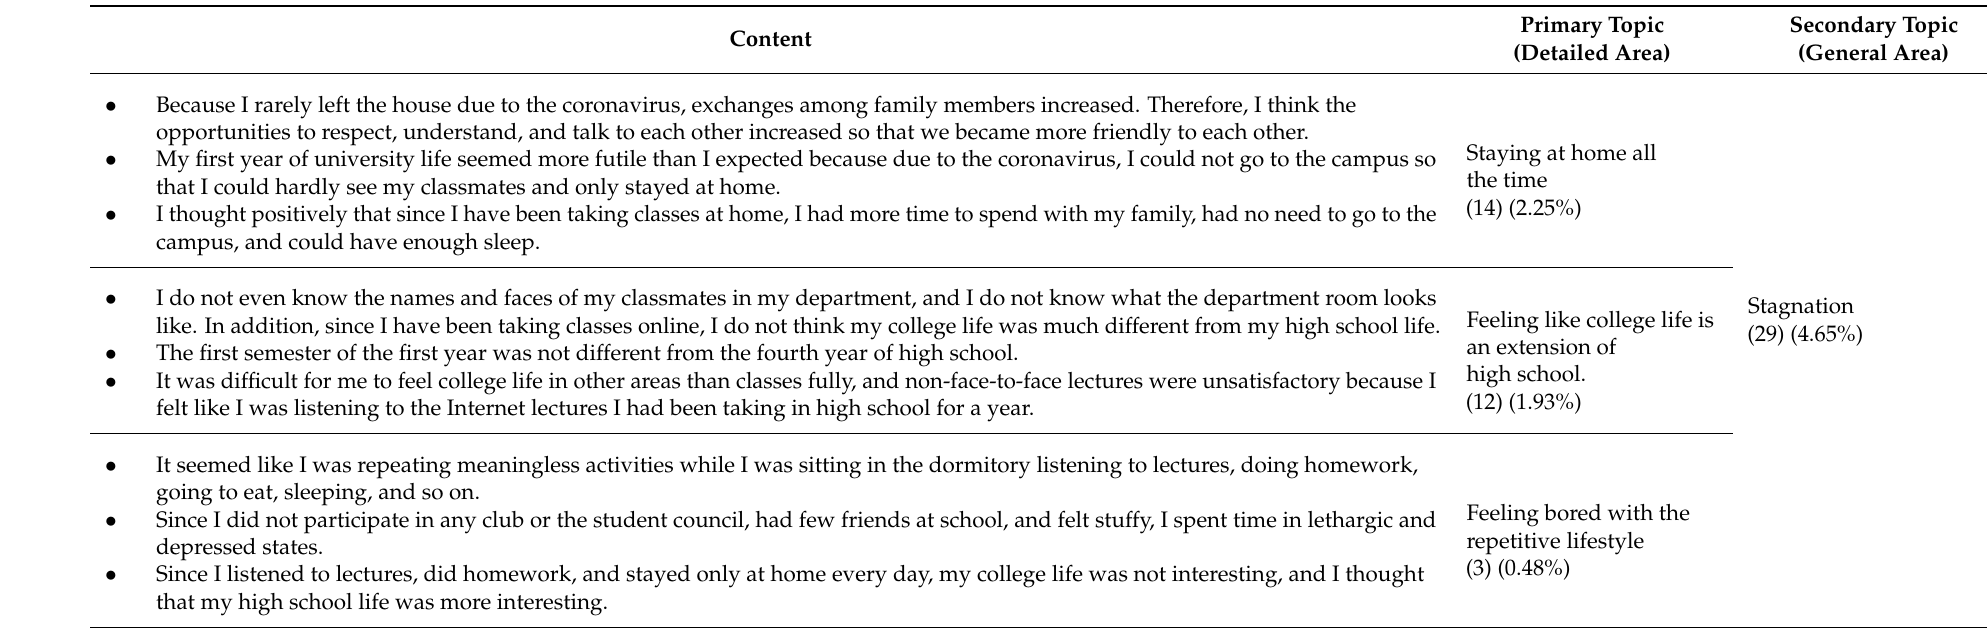
Table 3. Engagement in activities (n = 206)